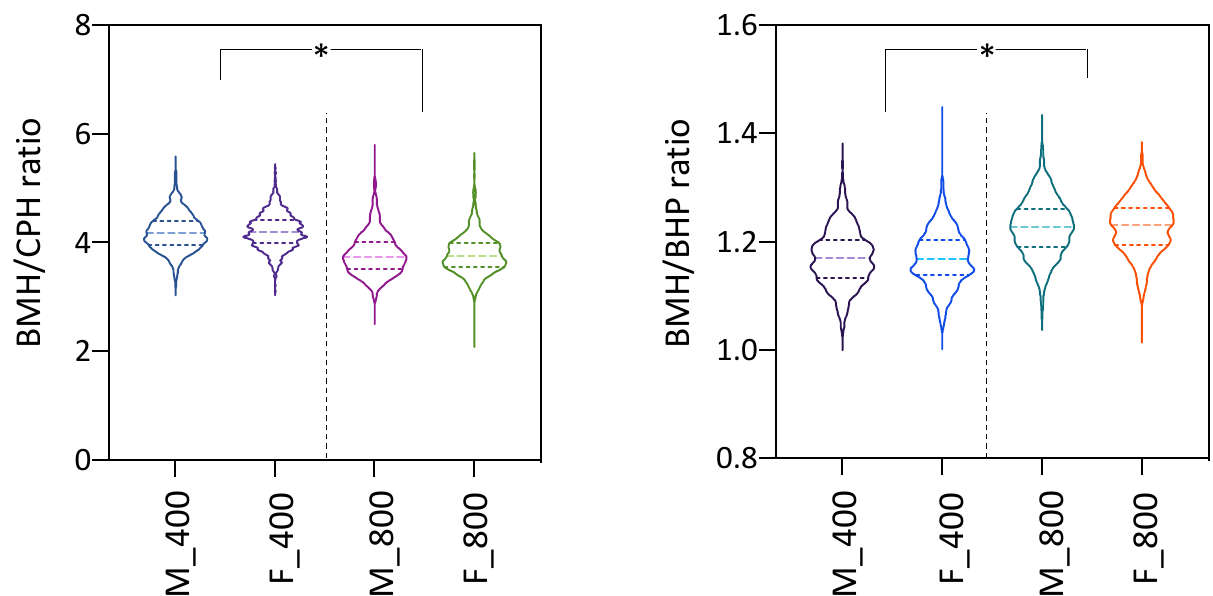
Figure 4. Violin plots for body maximum height (BMH) to caudal peduncle height (CPH) and BMH to body height at the insertion of the pectoral fin (BHP) ratios. Data for males (M) and females (F) at both 400 and 800 days (d) are indicated. The asterisk (*) denotes statistically significant differences between ages.